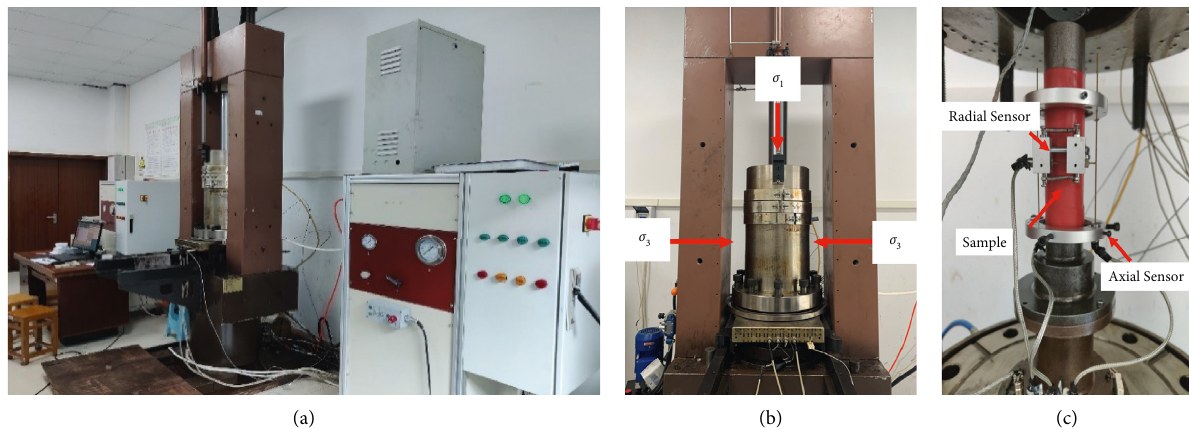
Figure 2: TFD-2000 microcomputer servo-controlled triaxial rheological testing machine. (a) The test system. (b) Confining pressure device and loading device. (c) Installation of rock specimens.